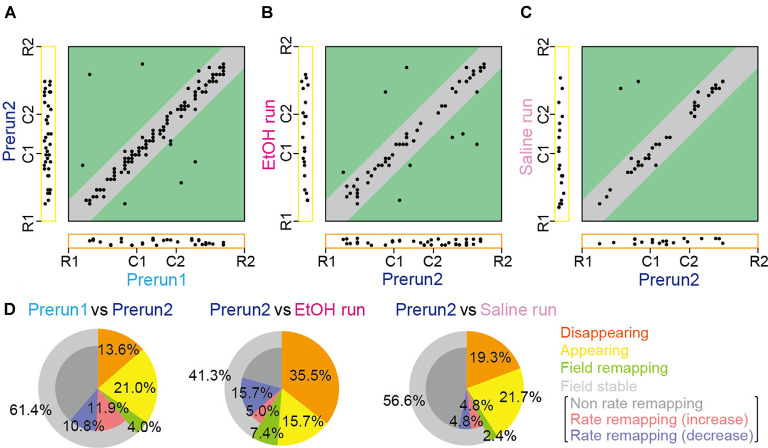
Changes in place cell firing patterns in ethanol-treated rats. (A) For each place field, the position of the place field center in the Prerun1 session was plotted against that in the Prerun2 session (n = 176 fields). Each dot represents an individual field. The Left and bottom areas represent fields that exhibited no spatial firing in one session but exhibited spatial firing in the other session, classified as appearing and disappearing types, respectively. Types of changes in spatial firing patterns are shown in the colored areas as follows: orange, disappearing; yellow, appearing; green, remapping; and gray, stable. (B) Same as (A) but plotted for firing patterns in the EtOH run session against those in the Prerun2 session (n = 121 fields). (C) Same as (A) but plotted for firing patterns in the Saline run session against those in the Prerun2 session (n = 83 fields). (D) The proportions of place field types, analyzed from (A–C).